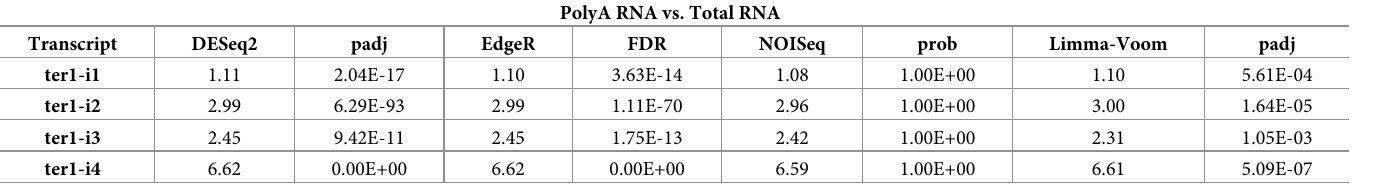
Table 1. Differential expression analysis of ter1